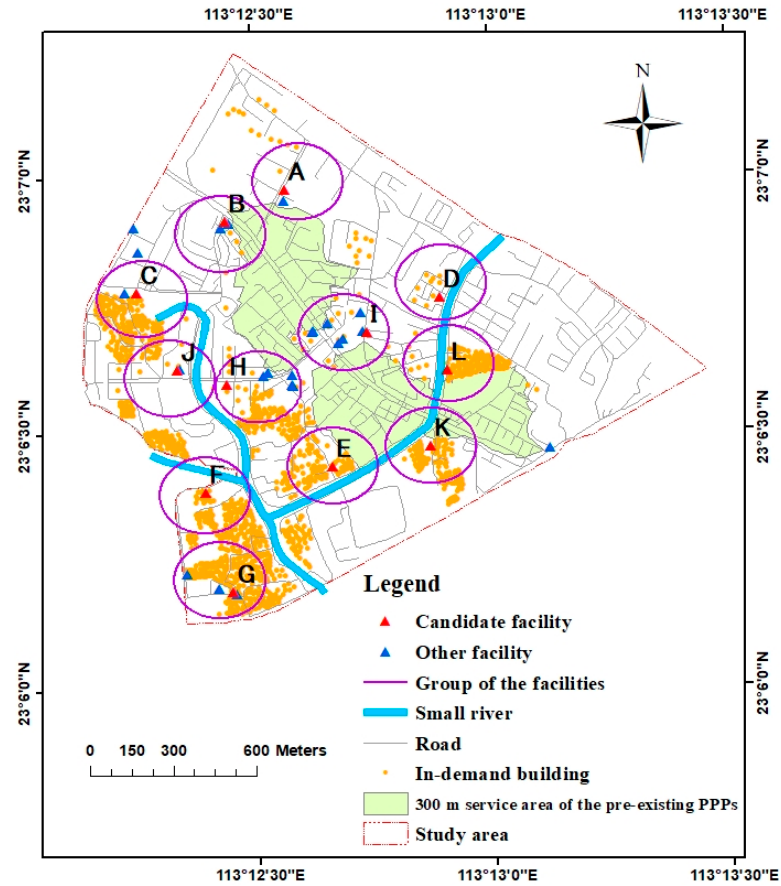
Figure 4. Location of the 12 selected candidate facilities.